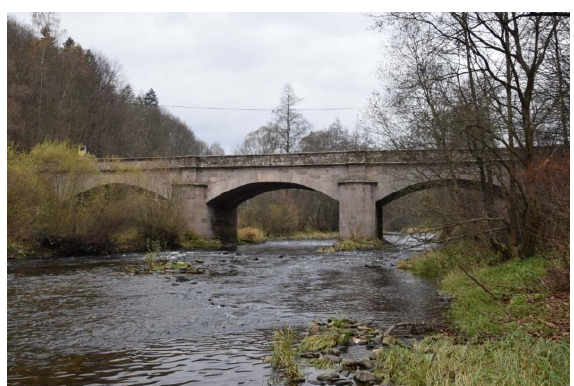
Figure 1. Front view of the sandstone bridge at